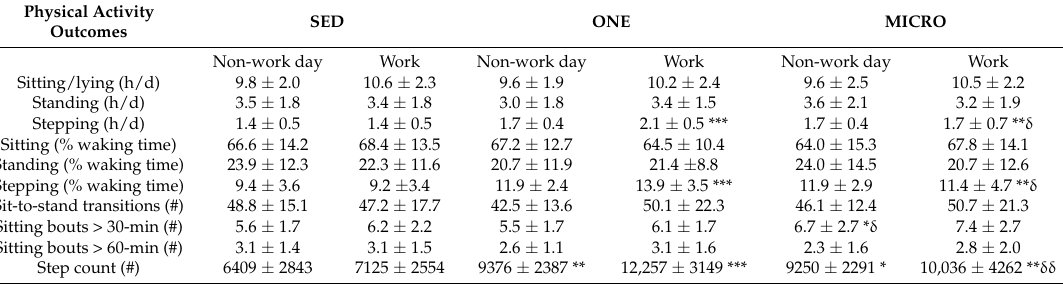
Table 2. Time spent sitting/lying, standing and stepping over 24hr and as percent of wake time. Physical Activity SED ONE MICRO Outcomes Non-work day Work Non-work day Work Non-work day Work Sitting/lying